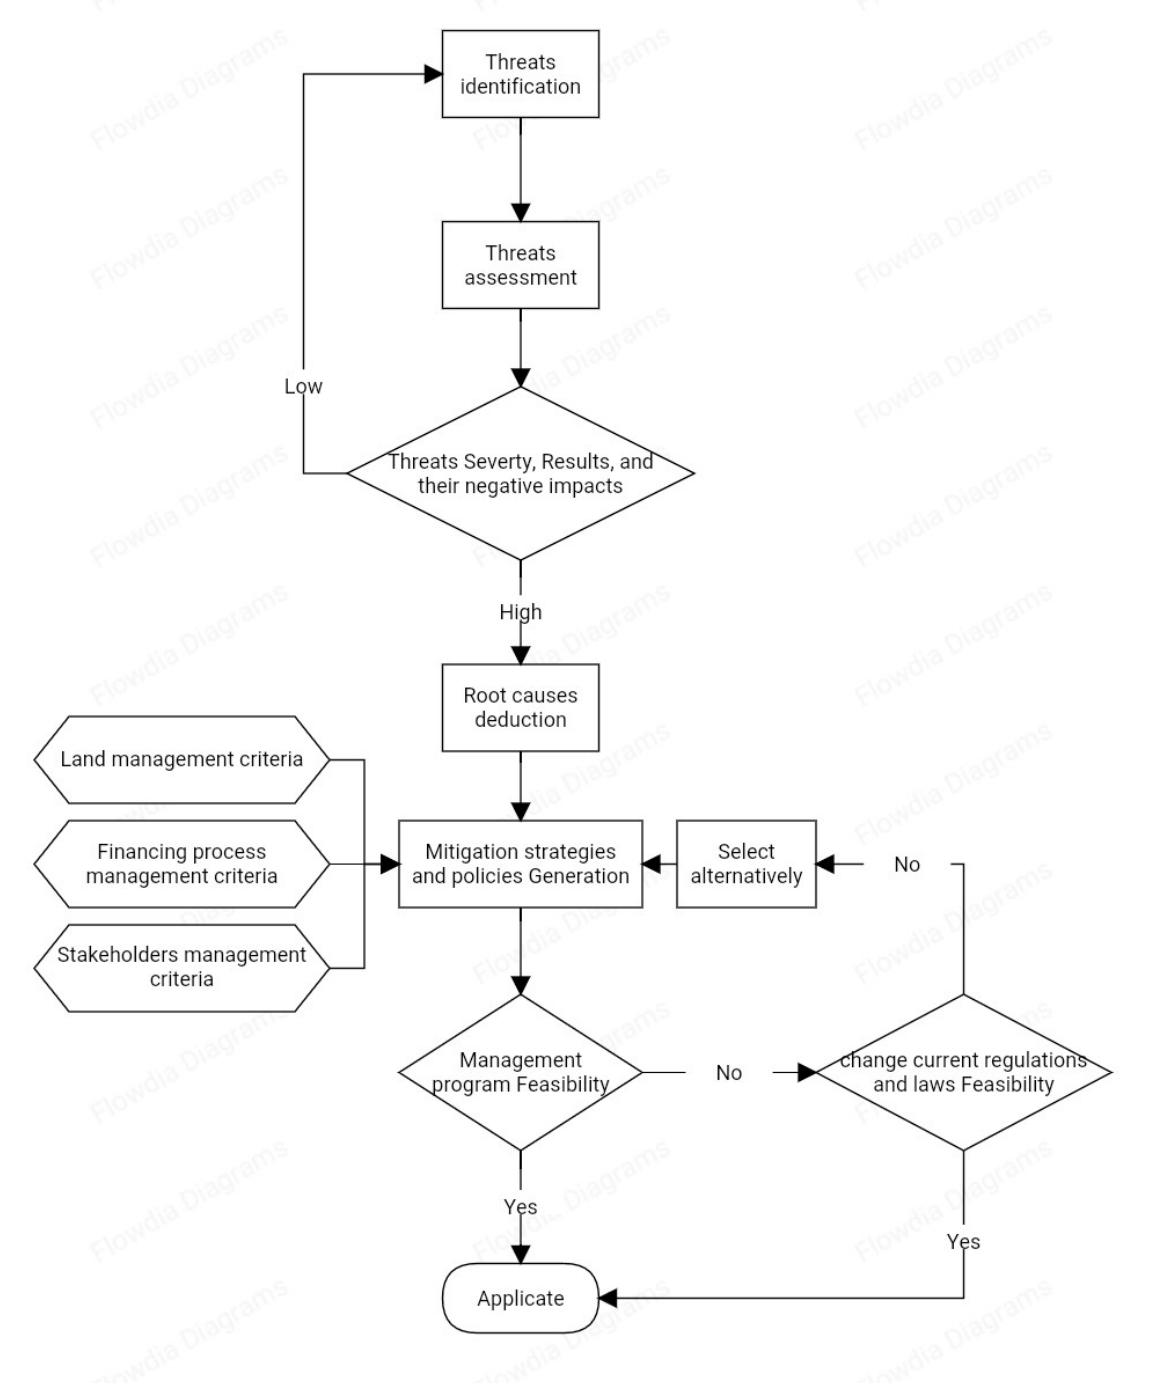
Figure 5. Public Land Asset Management Framework Flow Chart – Source: Author